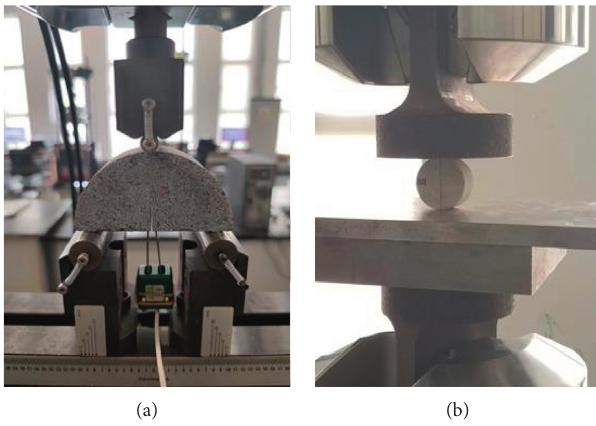
Figure 3: Fracture test and tensile strength